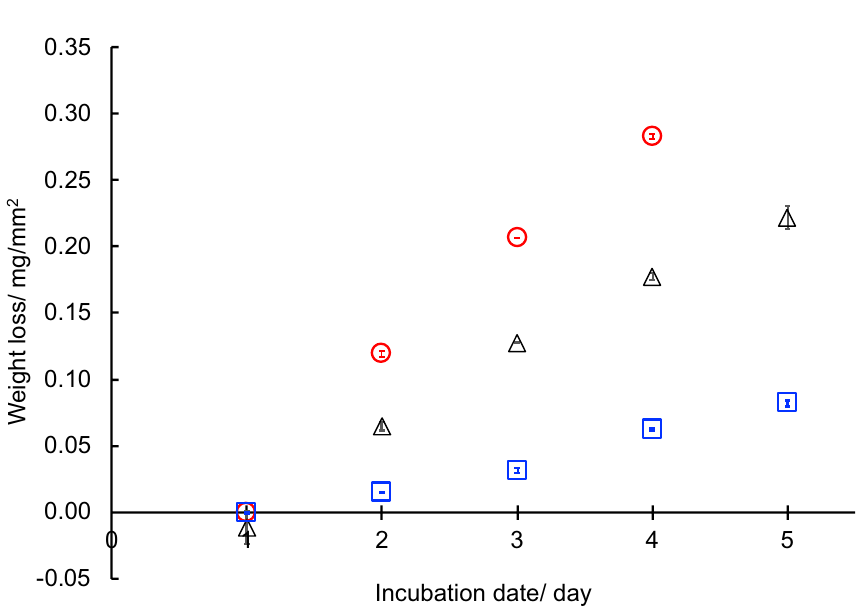
Figure 5. Enzymatic degradation of the BP1 sheets with Proteinase K (red circle), Pronase E (black triangle), and chymotrypsin (blue square) at 37 °C. Error bars indicate standard error. All experiments were performed in triplicate (n =